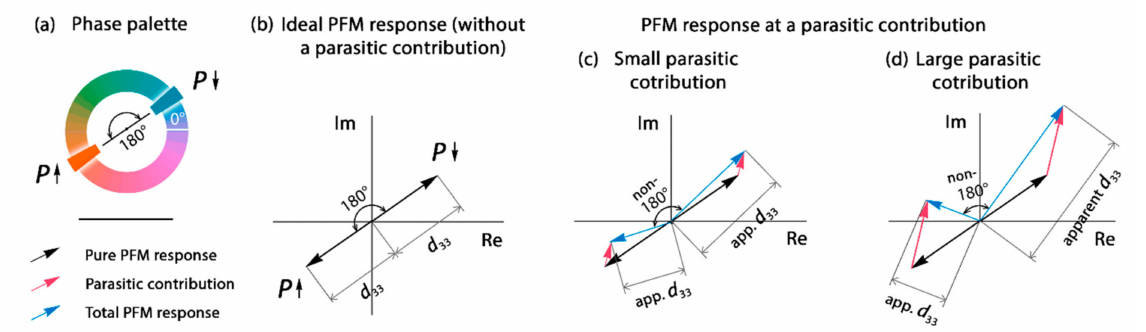
Figure 6. Complex PFM response for two polarization states and variations in the measured PFM phase and PFM amplitude at different conditions. ( a ) Phase palette used in Figure 3; ( b ) Ideal PFM response in the absence of parasitic contribution; PFM response at ( c ) small and ( d ) large parasitic contribution. Notation “ d 33 ” means real d 33 that was measured in PFM given the absence of a parasitic contribution. Notation “apparent d 33 ” (“app. d 33 ”) corresponds to the d 33 measured when a parasitic contribution was